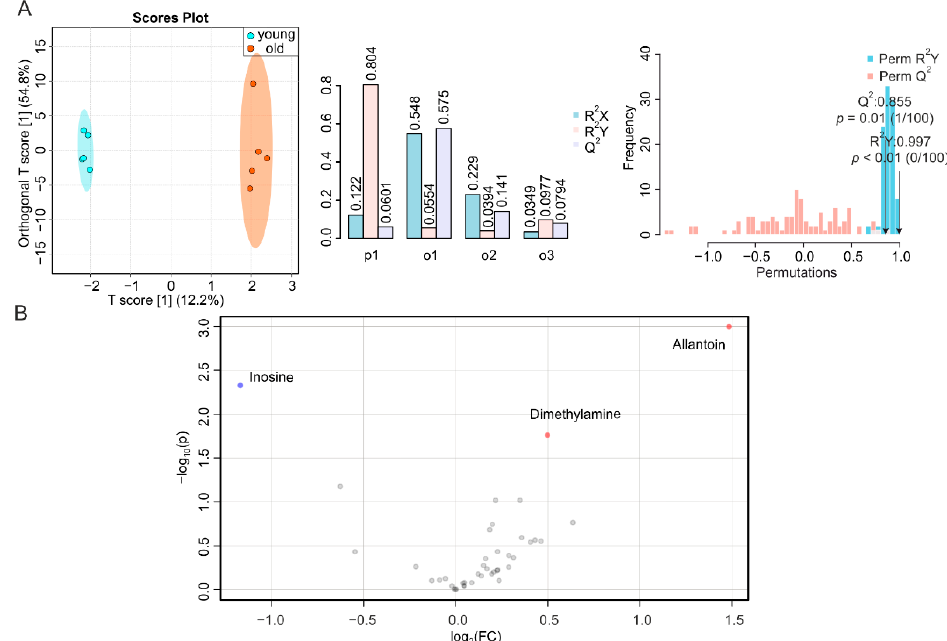
Figure 7. NMR-based metabolomics analysis of ileum. ( A ) O-PLS-DA plot and cross validation of ileum samples from young (blue) and old (orange) mice (left), with n = 5 each, and permutation between predictive component (p1) and three orthogonal components (o1, o2, o3) with cross-validated R 2 X, R 2 Y, and Q 2 coefficients (middle), and histogram showing permutation test with permutation number n = 100 (right). ( B ) Volcano plot of differentially regulated metabolites in ilea of young and aged mice. Increased (red) and decreased (blue) metabolites delimitate the fold change over aging, while grey dots denote insignificantly changed metabolites.